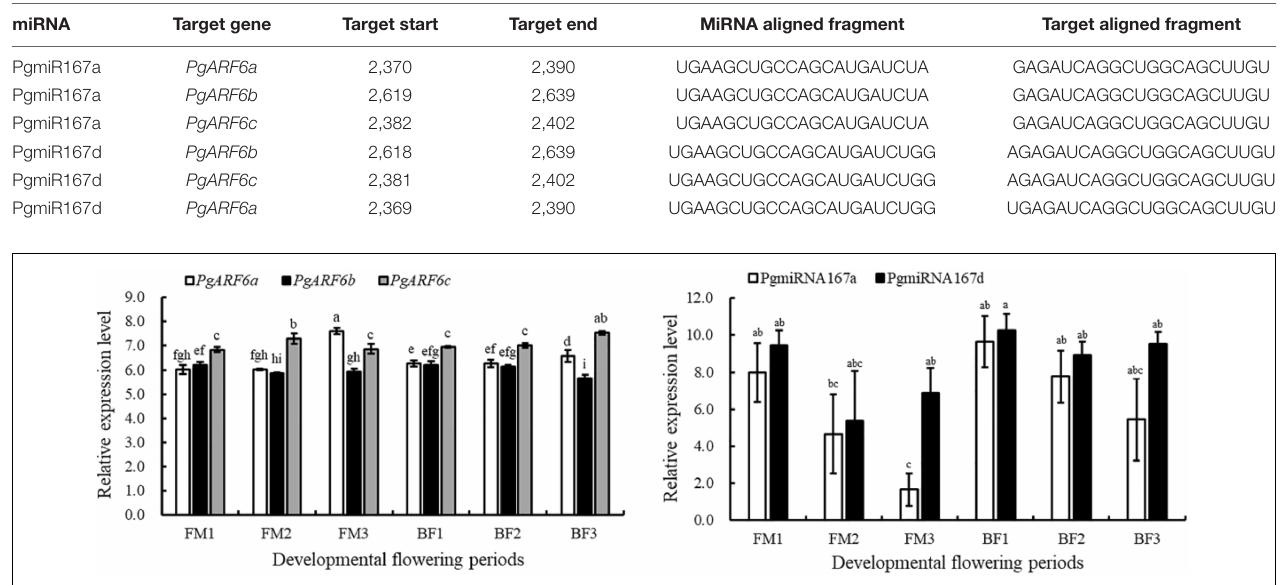
FIGURE 6 | Expression of PgARF6s transcripts during pomegranate flowers development. TABLE 2 | Prediction of targeting relationship between PgARF6s and PgmiR167 in pomegranate.